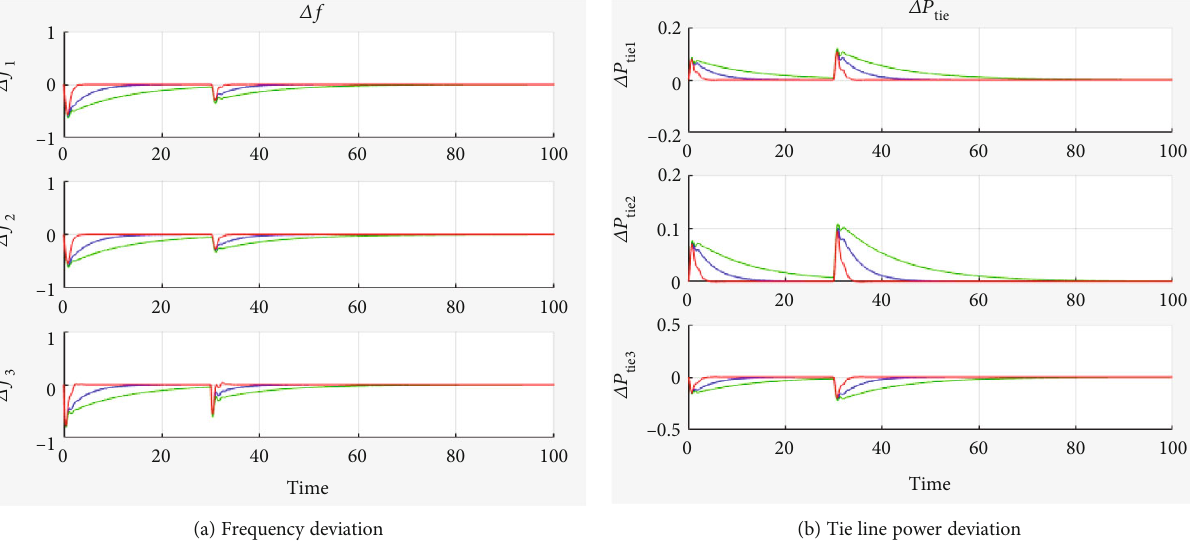
Figure 13: Response of the system under sudden load change from 0.5 to 0.9 p.u in area 3 at 30 seconds. deviation and frequency deviation of the three areas is shown The sudden load disturbance is created in area 2, i.e., the in Figure 13. The overshoot of the tie line power deviation load change in area 1 from 0.4 p.u to 0.2 pu at 40 seconds, and and frequency deviation in all areas is equal for GA, PSO, load pro fi le area 1 and area 3 is maintained at 0.2 pu. The cor- and WOA fuzzy PID. The recovery time of WOA fuzzy responding response of such a tie line power deviation and PID is 33 seconds, 42 seconds for PSO, and 72 seconds for frequency deviation of the three areas is shown in GA. Figure 12. The overshoot of the tie line power deviation The sudden load disturbance is created in all the areas, and frequency deviation in all areas is equal for GA, PSO, i.e., the load change is from 0.2 p.u to 0.4 p.u in area 1 at 30 and WOA fuzzy PID. The recovery time of WOA fuzzy seconds, the load change is from 0.4 p.u to 0.2 p.u in area 2 PID is 45 seconds, 50 seconds for PSO, and 67 seconds for at 60 seconds, and the load change is from 0.5 p.u to 0.9 GA. p.u in area 3 at 90 seconds. The corresponding response to The sudden load disturbance is created in area 3, i.e., the such a tie line power deviation and frequency deviation of load change in area 1 is from 0.5 p.u to 0.9 pu at 30 seconds, the three areas is shown in Figure 14. The overshoot of the and the load pro fi les in area 1 and area 2 are maintained at tie line power deviation and frequency deviation in all areas 0.2 pu. The corresponding response to such a tie line power